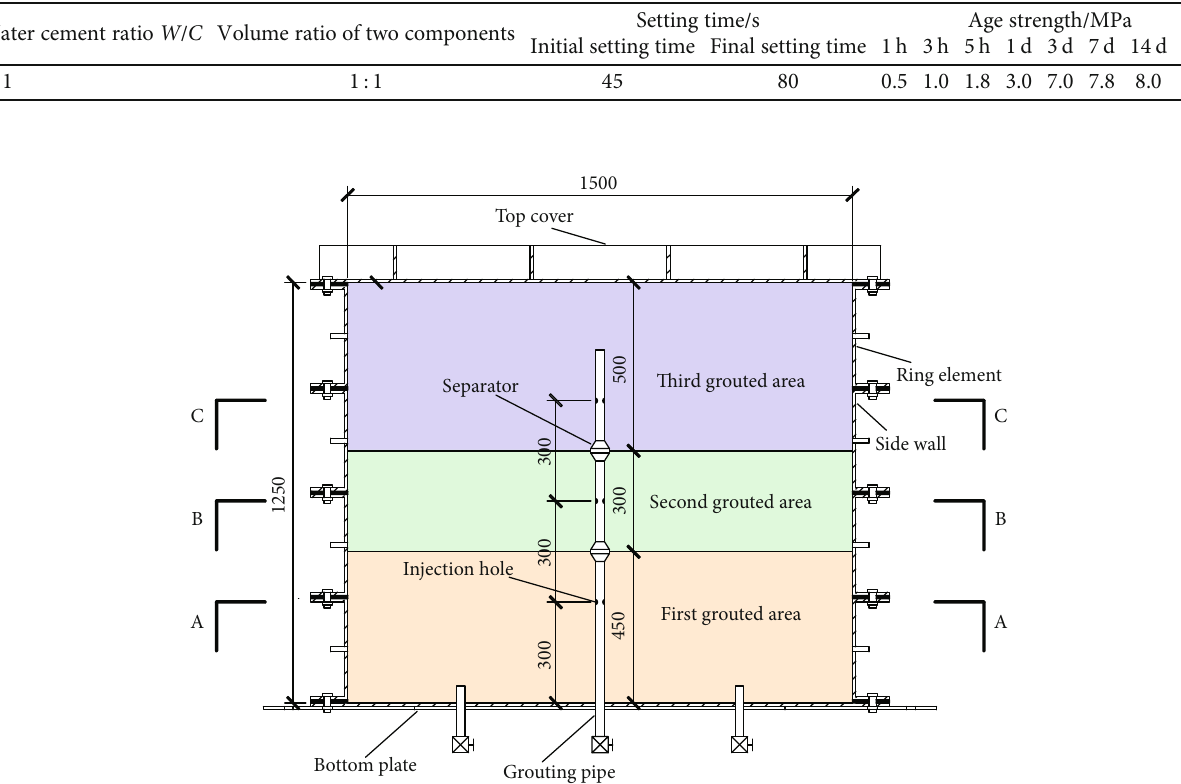
Table 2: Parameters of grout material.